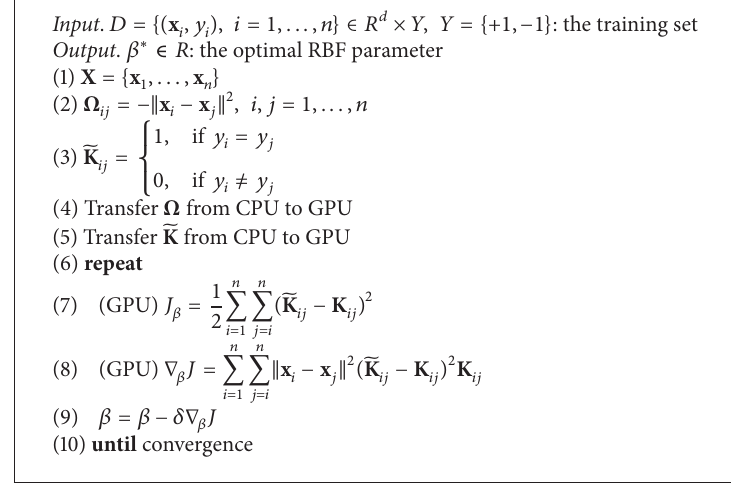
Algorithm 2: GPU code of gradient descent algorithm for obtaining the optimal RBF